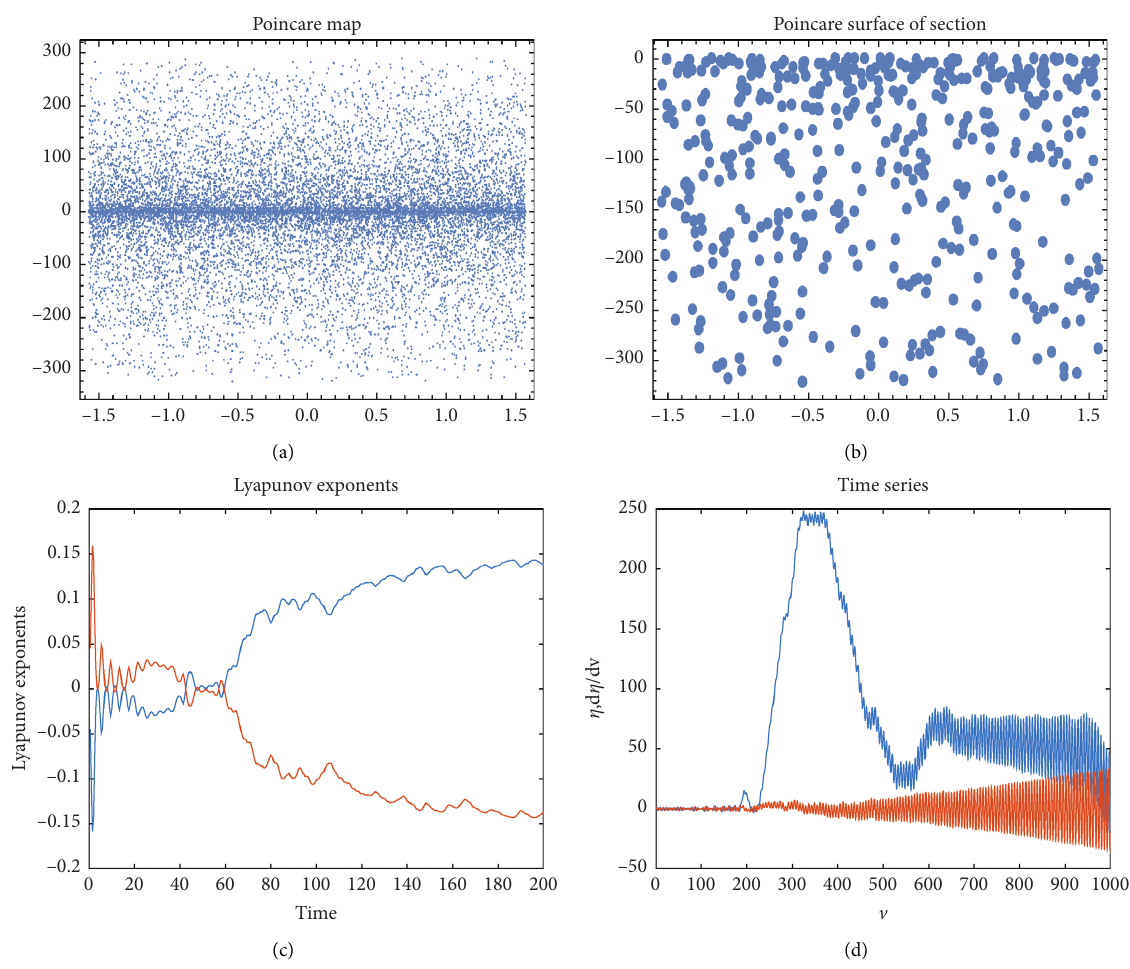
Figure 5: For n � 0 . 9 , ε � 0 . 00000000000001 ,A 0 . 001. (a) Poincare map, (b) Poincare surface of section, (c) Lyapunov exponent, and (d) time series. Table 2: Earth-Resourcesat-1 system for fixed values of A � 200 . 1022 , e � 0 . 001 ,n, and variationin ε . Figure no.